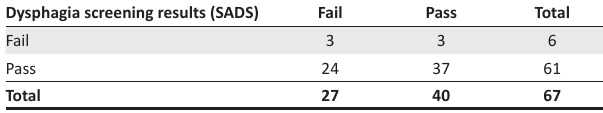
TABLE 3: Calculation of percentage of agreement.